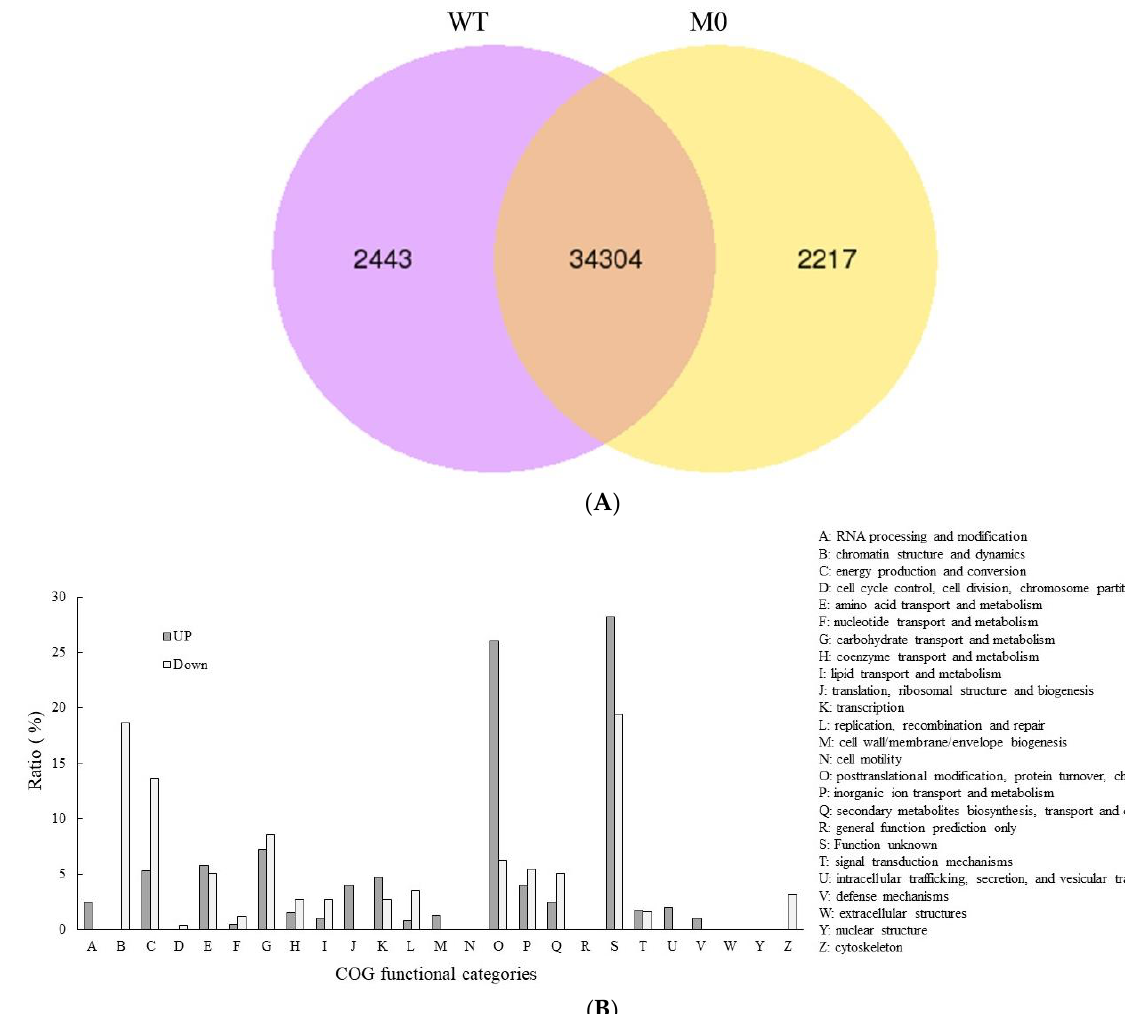
Figure 4. The functional classification based on clusters of orthologous groups (COG) for differentially expressed genes between PEP-deficient tobacco and wild-type plants. ( A ). A Venn diagram of the differentially expressed genes is shown. The sum of the numbers in each circle is the total number of genes expressed in PEP-deficient (M0) tobacco or wild-type (WT) plants. The overlapping region represents the genes expressed in common in both M0 and WT tobacco. ( B ). The ratio of up-regulated (grey bar) or down-regulated (white bar) DEGs in each annotated COG functional category between PEP-deficient (M0) tobacco and wild-type (WT) plants. The COG functional categories are shown on the right.